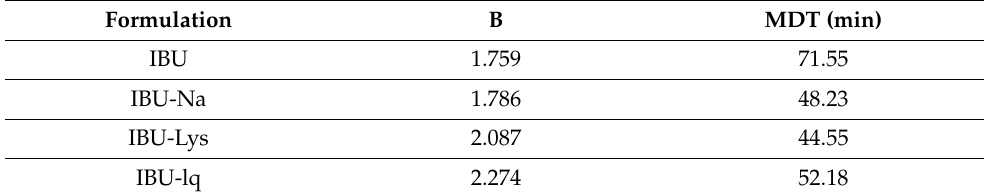
Figure 9. Absorption profiles obtained by deconvolution of clinical data [23]. Table 5. Estimated parameters of the Weibull